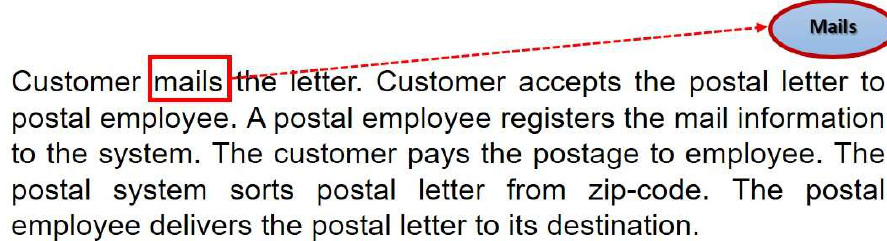
Figure 8. Key verb identification of requirement analysis.